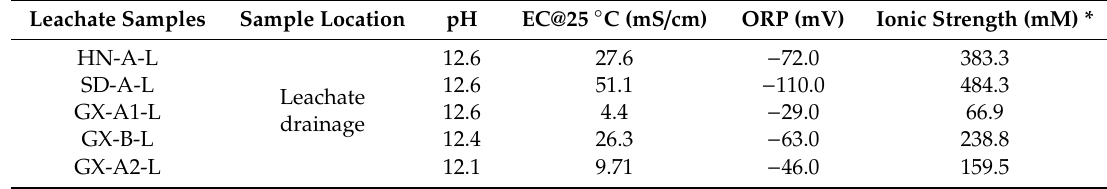
Table 5. Bulk chemical parameters of red mud leachate samples from the current study.